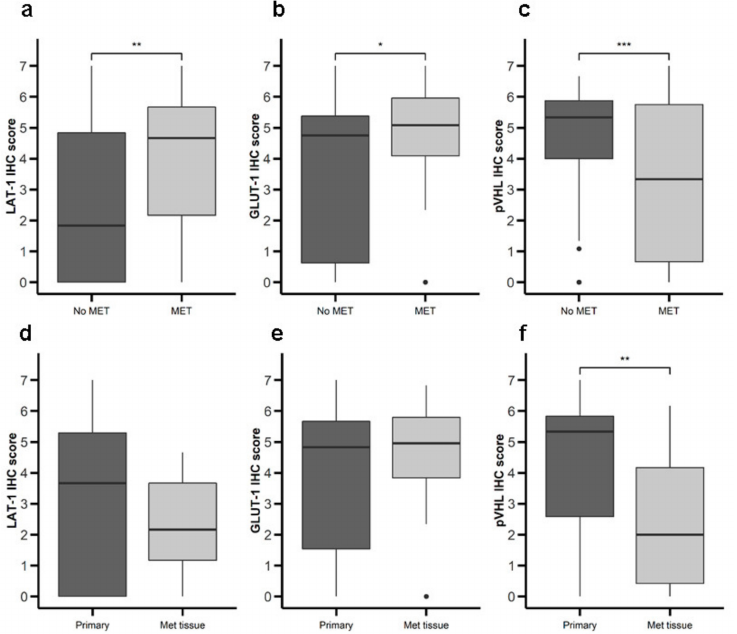
Figure 4. Expression of nutrient transport components and Von Hippel Lindau(VHL) in primary NETs with or without metastasis. LAT-1, GLUT-1, and pVHL were measured by IHC in a set of TMAs ( n = 164) from GEP-NETs. Values are represented as boxplot of IHC scores. ( a – c ) Samples were classified based on metastatic status at the time of diagnosis: patients with metastasis (MET) or without metastasis (No MET). ( d – f ) Primary tumor tissue samples were compared to metastatic tumor tissue. Boxplots visualize five statistics (the median, first quartile, third quartile, and two whiskers). The upper and lower hinges correspond to the third (75th percentile) and first (25th percentile) quartiles. The upper whisker extends from the hinge to the largest value no further than 1.5 fold interquartile range (IQR) of the hinge. The lower whisker extends from the hinge to the smallest value at most 1.5 fold IQR of the hinge. Asterisks indicate significant di ff erences between tumor and peritumoral tissues (* p < 0.05, ** p < 0.01, *** p <